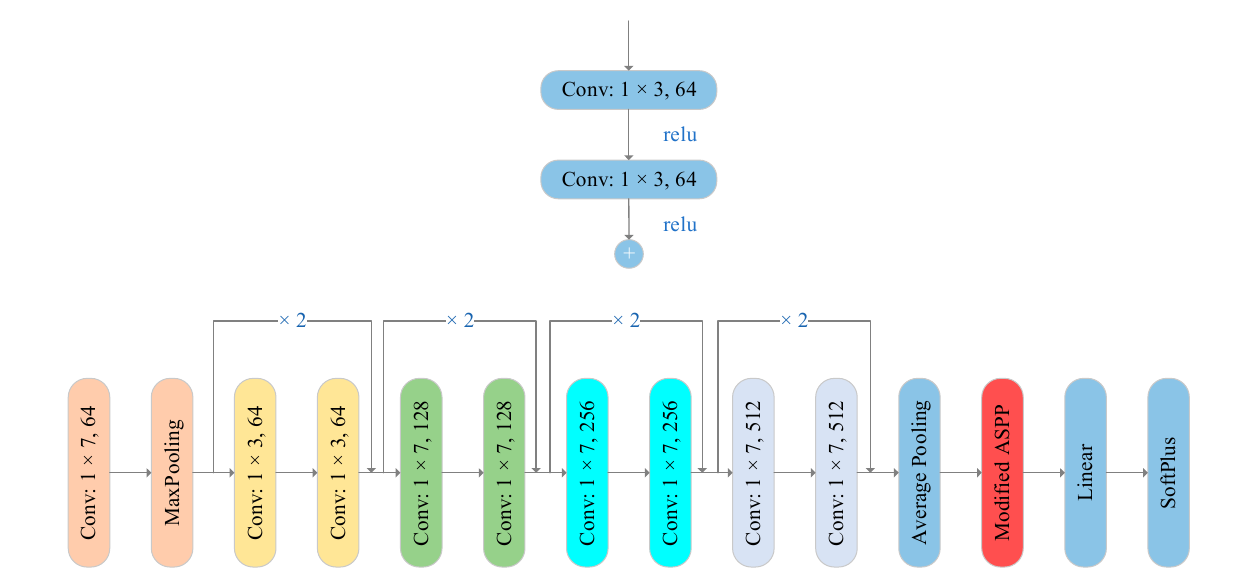
Figure 4. Modified Resnet18 (1D and 2D) basic block and simplified structure.